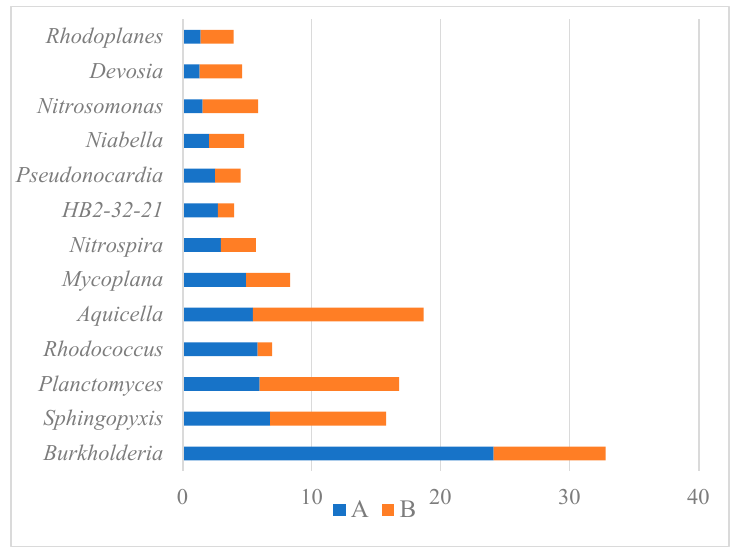
Figure 8. Percentage share of the most frequent identified genera in the examined samples.